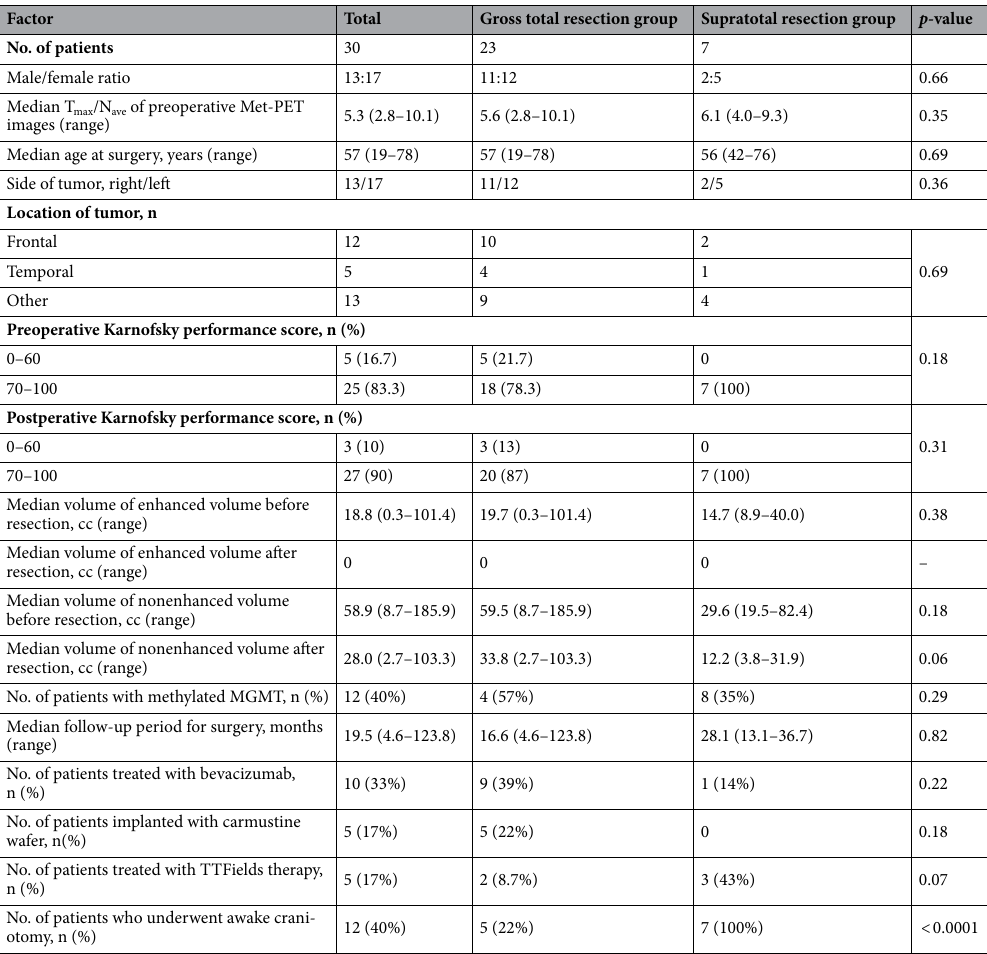
Table 1. Clinical characteristic of 30 newly diagnosed glioblastoma patients. Met-PET 11